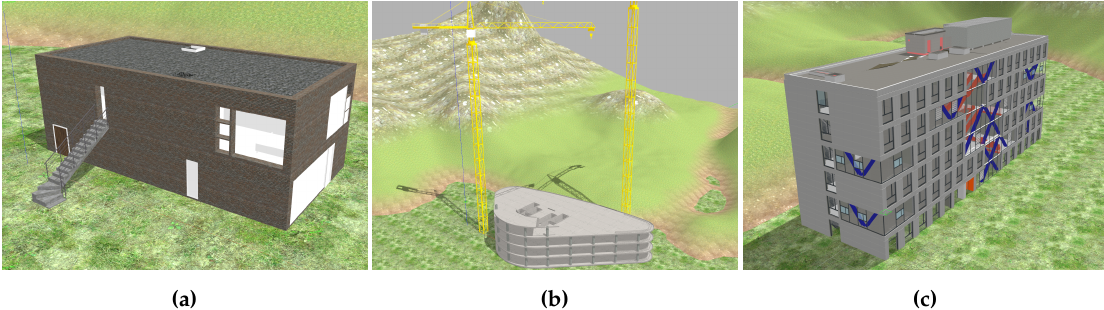
Figure 6. Three simulation scenes with construction states derived from BIM. ( a ) Duplex apartment building. ( b ) Mefisto construction model. ( c ) Hochschule Bochum (HSBO) building model.